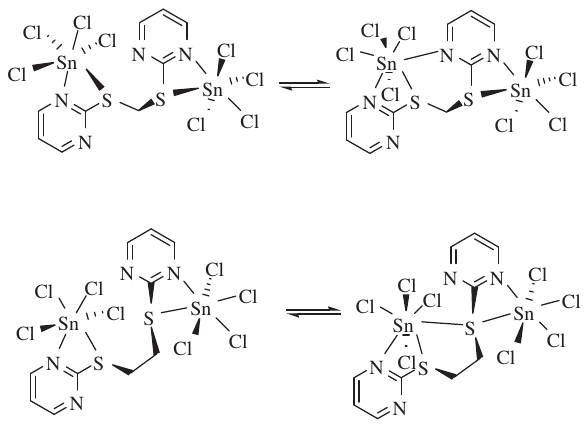
Figure 3 Chemical equilibrium involving [Sn and [Sn